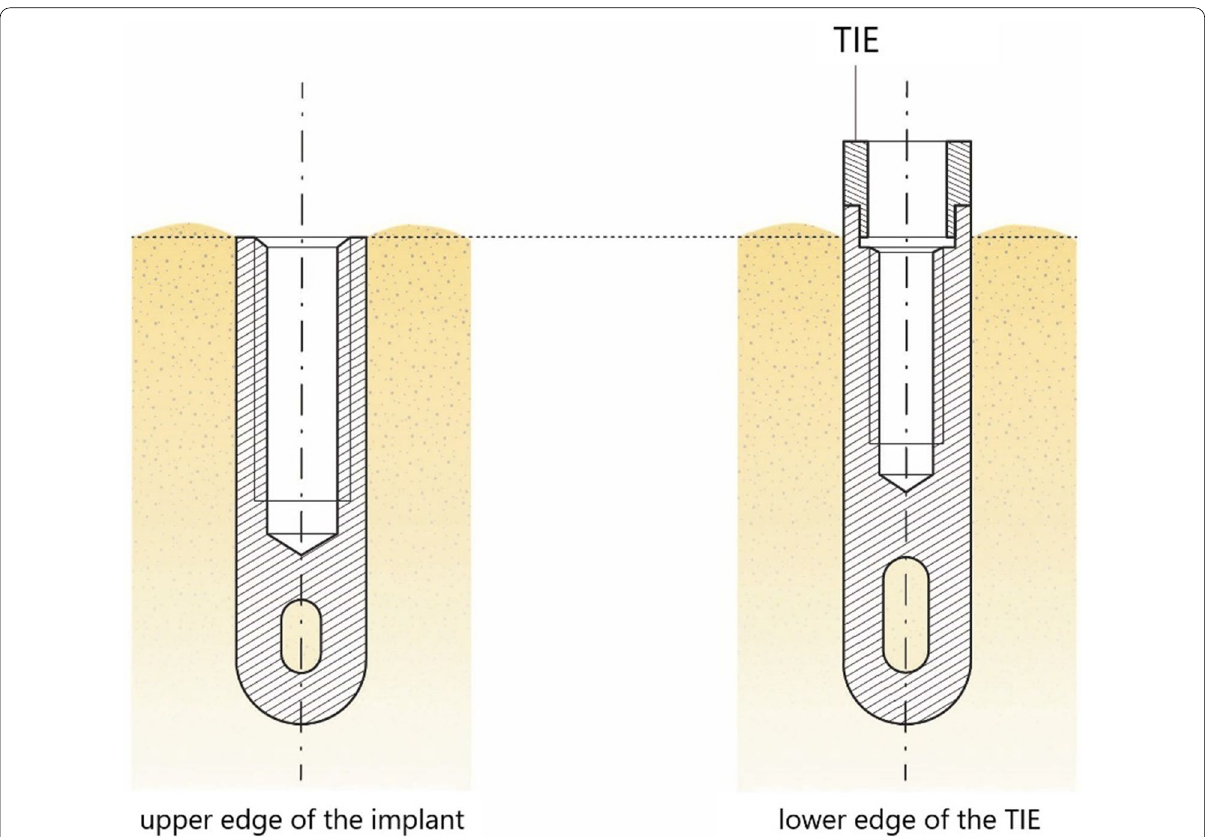
Fig. 3 Reference points for radiographic measurements of the marginal bone level for IMZ implants with and without transmucosal implant extension (TIE). Implants were placed into the bone as far as these reference